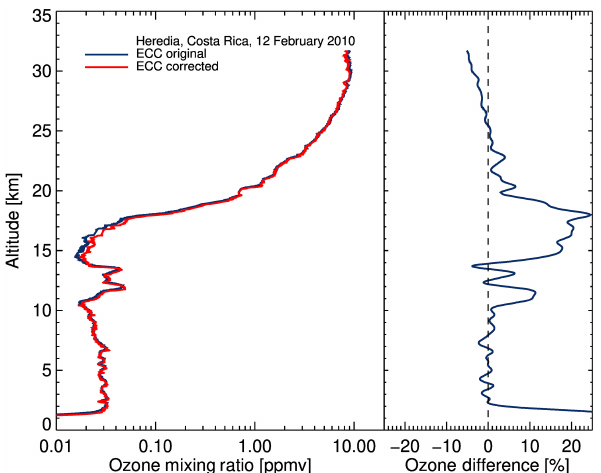
Figure 6. Comparison between ECC and OPM mixing ratio in 77 simulation experiments during JOSIE 2017. The originally reported difference is shown in blue; the difference calculated using the cor- rected data is shown in red. The shaded areas indicate the standard error. Dotted lines indicate ± 3%.